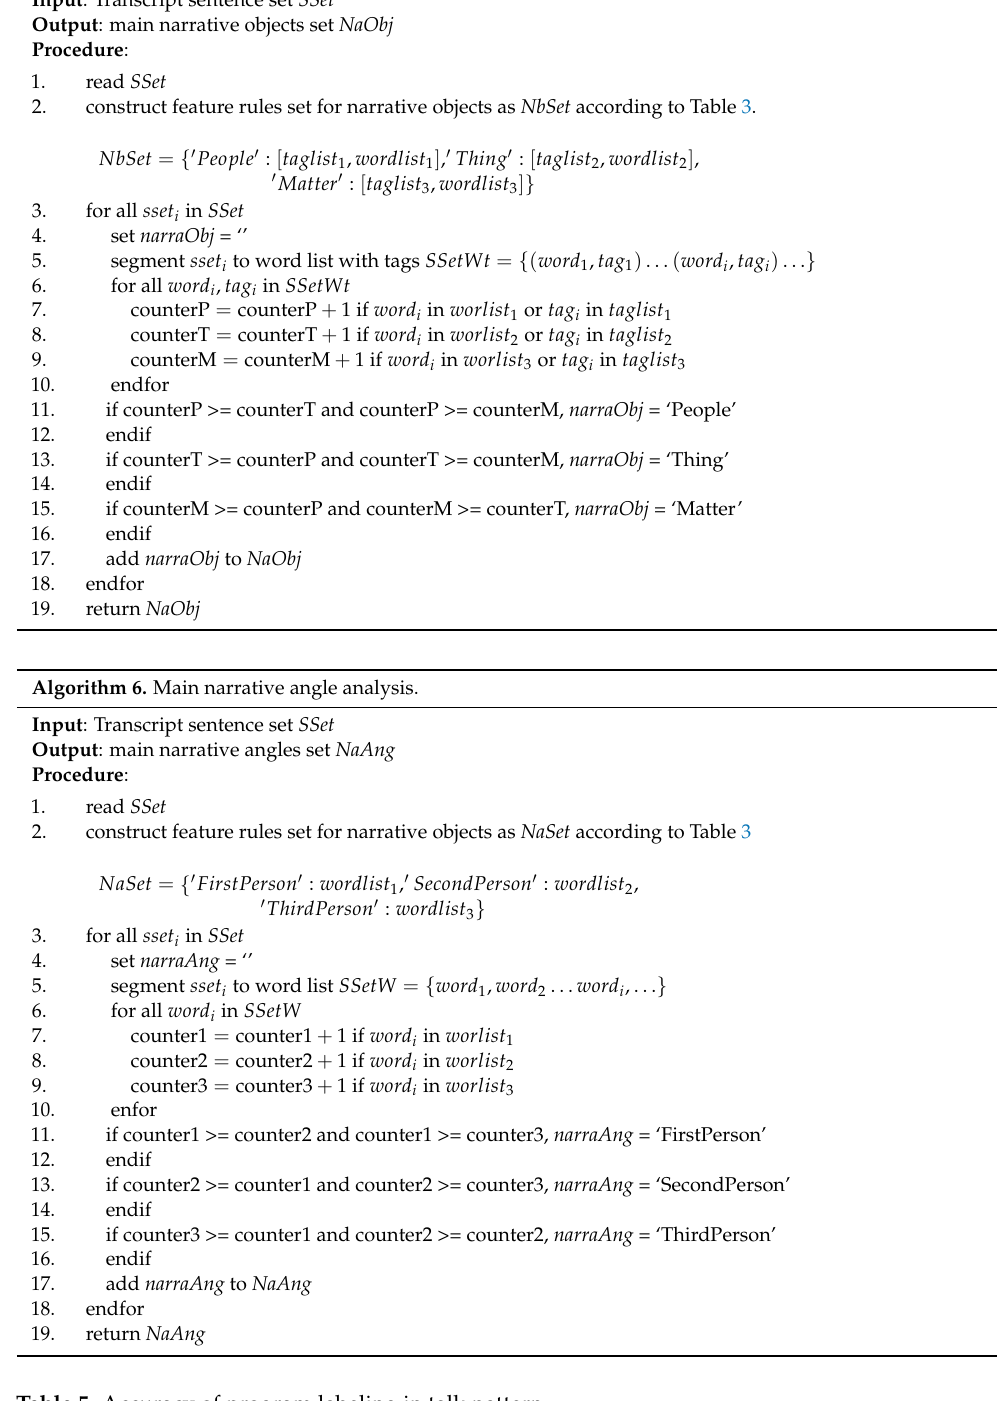
Table 5. Accuracy of program labeling in talk